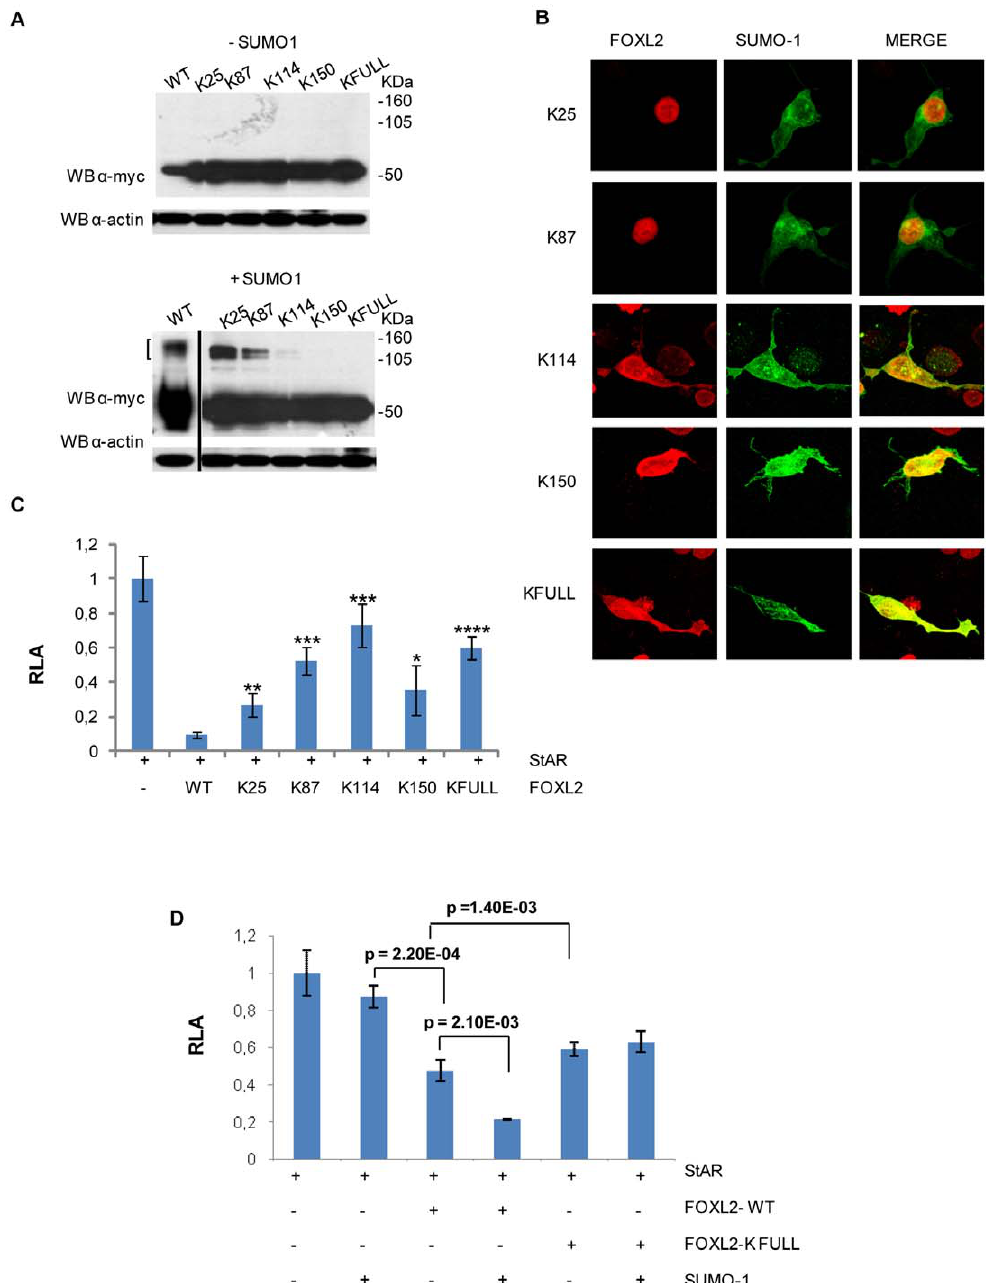
Figure 5. Identification and characterization of putative FOXL2 sumoylation sites. A. Mutations of K114, K150 and KFULL results in a strong reduction of the largest sumoylated band: COS 7 cells were transfected with pCRUZ-myc-FOXL2 wild type or in the mutated forms, with and without pCRUZ-HA-SUMO-1. 48 h after transfection cells were lysed and 50 ug of protein were analysed by western blotting with anti-myc antibody. The largest sumoylated band is absent in K114, K150, and K-FULL. B. Mutation of K114 or K150 affects FOXL2 cellular localization: pCRUZ-myc-FOXL2 (WT, K25R, K87R, K114R, K150R, FULL) and pCRUZ- HA-SUMO-1 were co-transfected in COS-7 cells. The intracellular distribution of FOXL2 (red) and SUMO-1 (green) was detected by indirect immunofluorescence with mouse anti-myc and rabbit anti-HA primary antibodies and Alexa Fluor 633 anti- mouse and Alexa Fluor 488 anti-rabbit secondary antibodies. Yellow spots show the overlap (co-localization) of the two signals. C., D. Mutation of putative sumoylation sites results in changes of FOXL2 transcriptional activity: (C) COS-7 cells were co-transfected with pGL3-StAR luciferase reporter vector and wild-type or mutated FOXL2. Reporter Luciferase activity expressed from the StAR promoter was measured. Luciferase activity is reported as relative activity. It is the mean of at least 4 independent experiments, normalized to the reporter gene Renilla , encoded by a pTRLK vector, used as an internal control, and compared to promoter activity alone. Significance was estimated using Student’s t-Test, (*) p , 0.01, (**) , 0.001, (***) , 0.0001, (****) , 10 2 7 (D) COS-7 cells were co-transfected with pGL3-StAR luciferase reporter vector, and pCRUZ-myc-FOXL2 wild-type or pCRUZ-myc-FOXL2- KFULL, with or without pCRUZ-HA-SUMO-1. The mutation of all 4 putative sumoylation sites (FOXL2-KFULL) leads to a level of FOXL2 inhibition independent of the addition of SUMO-1, whereas wild-type mediated inhibition is increased by SUMO-1. Significance was estimated using Student’s t-Test and reported in the chart.